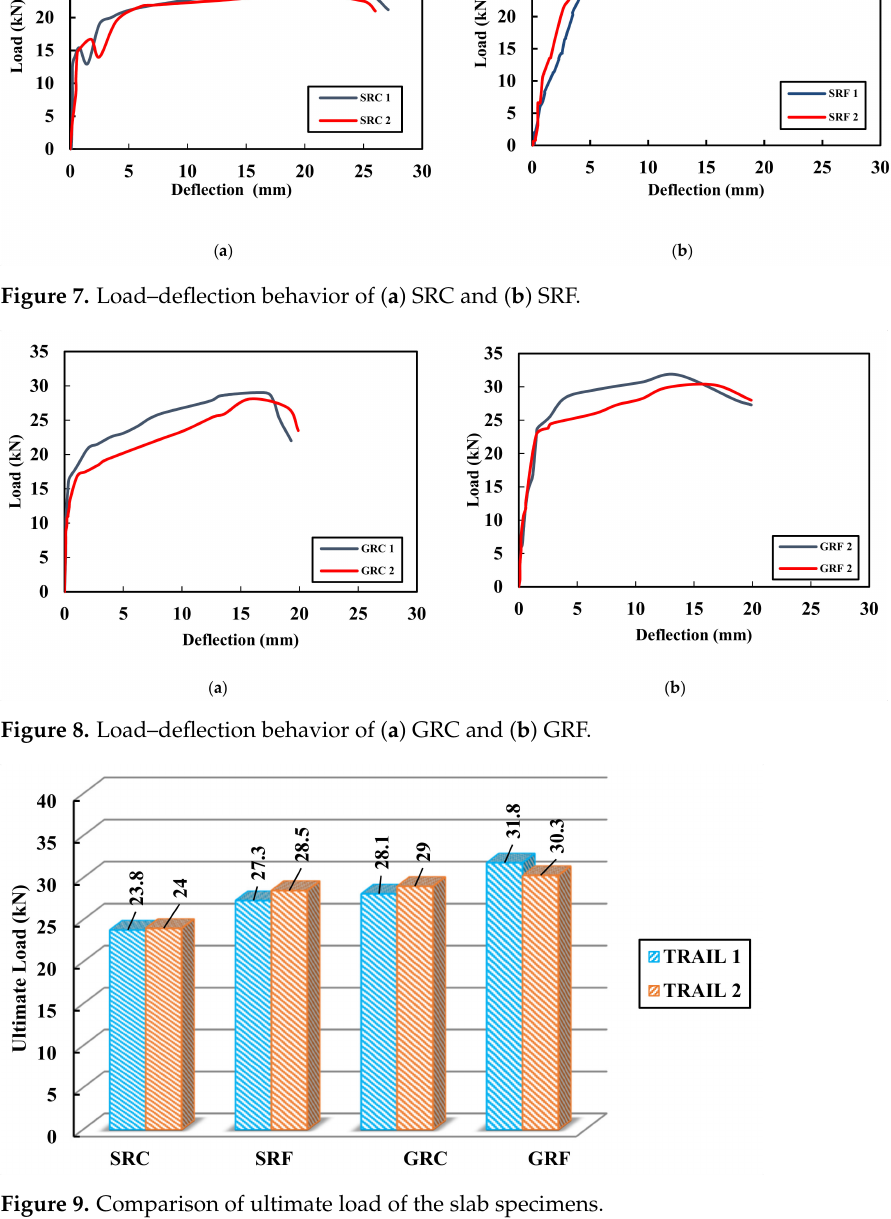
Figure 9. Comparison of ultimate load of the slab